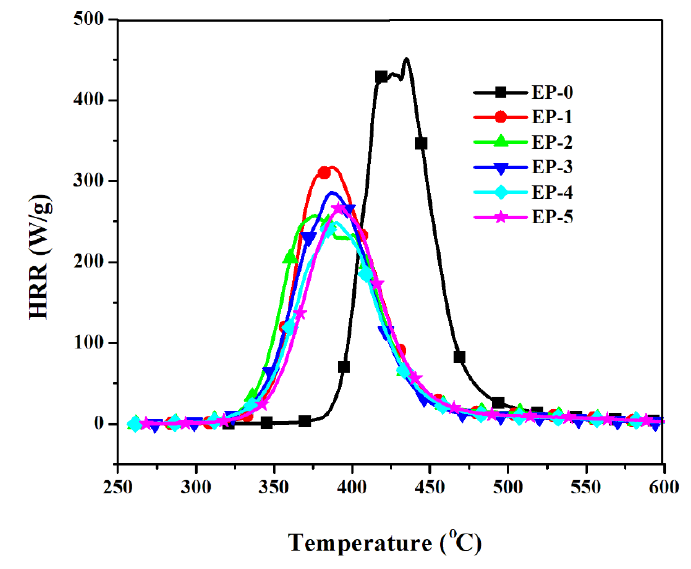
Figure 9. Heat release rates versus temperature for epoxy